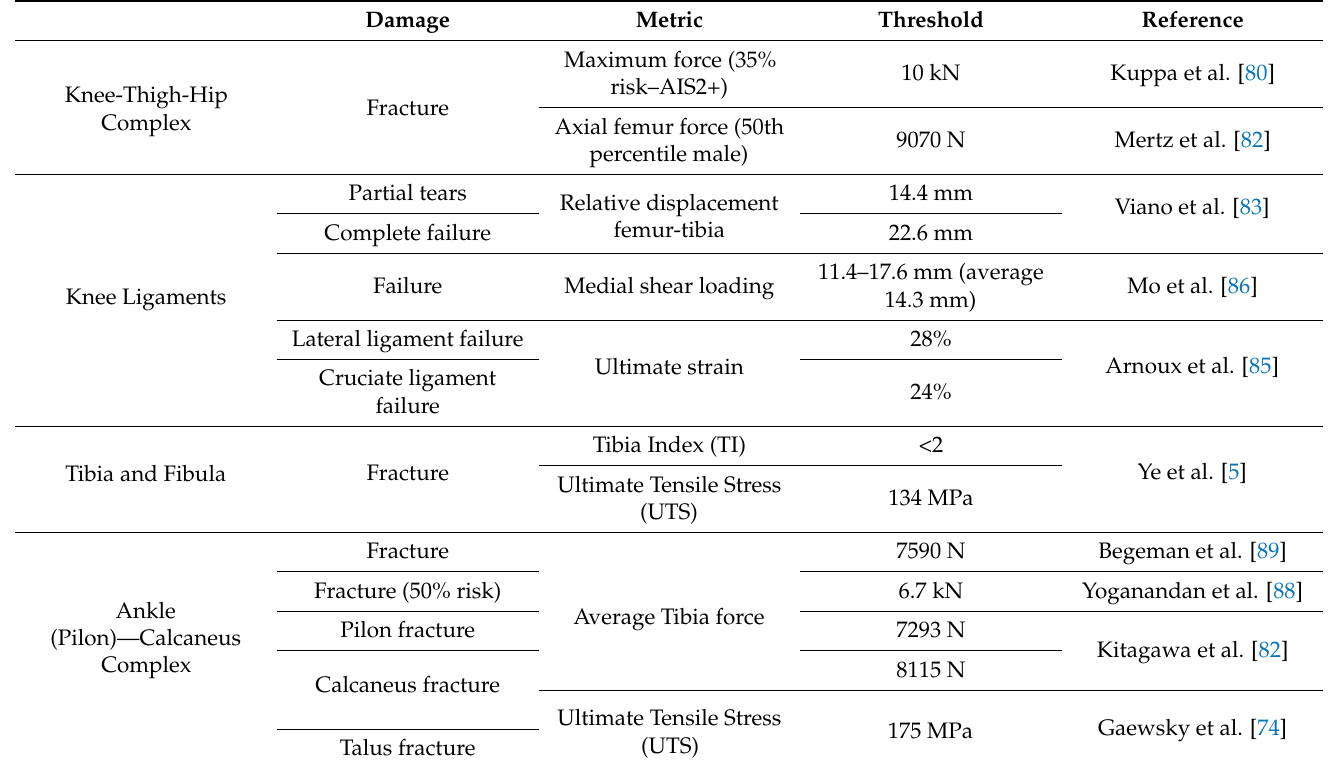
Table 5. Summary of the main IC proposed for the lower